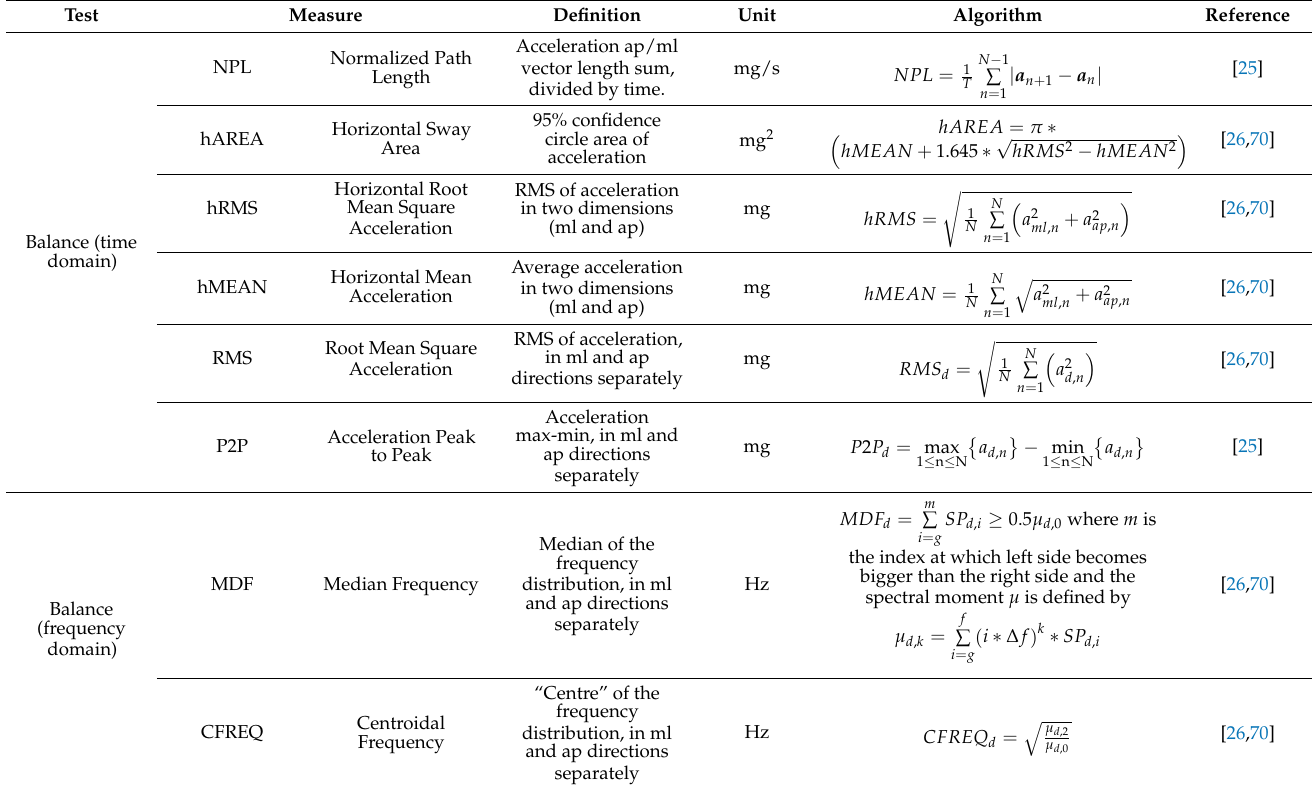
Table 1. Sensor measurement variables for the Standing balance test (balance) and Three Maximal Chair Stand Test (leg